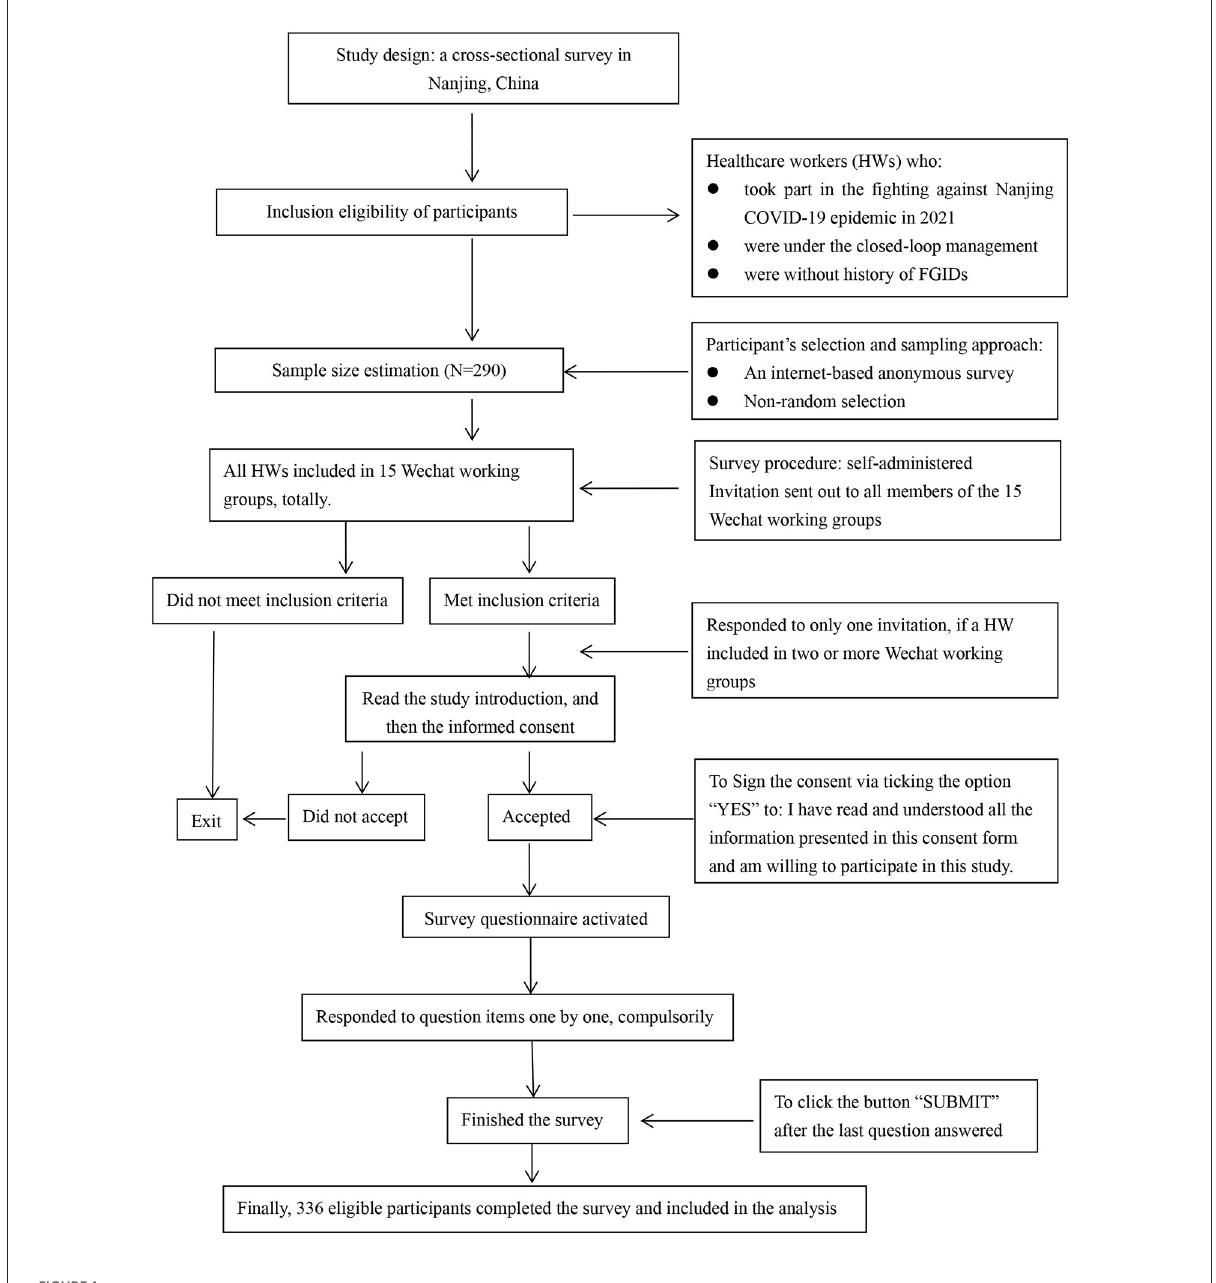
FIGURE1 Flowchart of participant’s selection and survey procedure in the